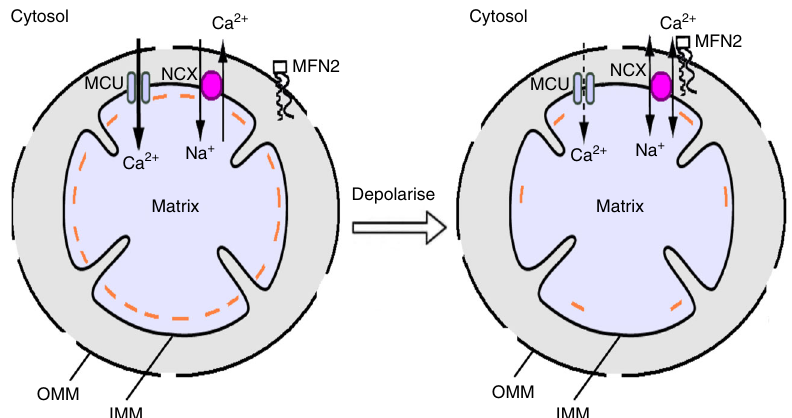
Fig. 5 Cartoon summarises Na + – Ca 2+ exchanger transport in mitochondria under the conditions shown The left-hand panel depicts the situation in energised mitochondria. The exchanger operates in forward mode, transporting cytosolic Na + into the matrix in exchange for matrix Ca 2+ , which has entered through the MCU. Mitofusin 2 is located in the OMM and functionally detached from the exchanger. After mitochondrial depolarisation (right- hand panel), the exchanger is now functionally coupled to mitofusin 2 and can operate in both forward and reverse modes. OMM denotes